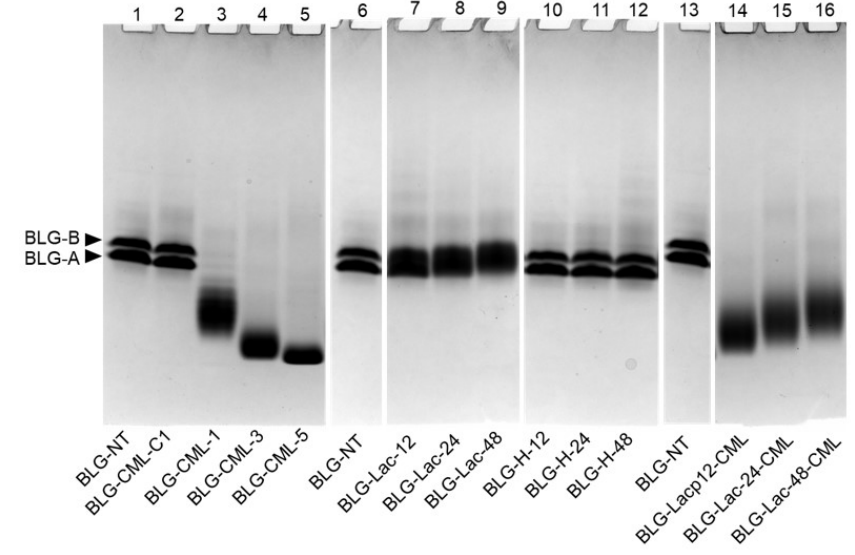
Figure 4. Native-PAGE of β -lactoglobulin (BLG), non-treated (NT), chemical modification control (C1), chemically modified to introduce N ε -carboxymethyl lysine (CML) at di ff erent degree of modification (1, 3, and 5), glycated with lactose (Lac) by heating at 60 ◦ C for 12, 24, and 48 h; heated at 60 ◦ C for 12, 24, and 48 h in the absence of any sugars (H), and glycated by heating with lactose followed by CML induction with glyoxal. BLG-NT of lane 1 and 13 are identical and were on the same gel as samples in lane 2–5 and lane 14–16, whereas BLG-NT in lane 6 was run on the same gel as samples in lane